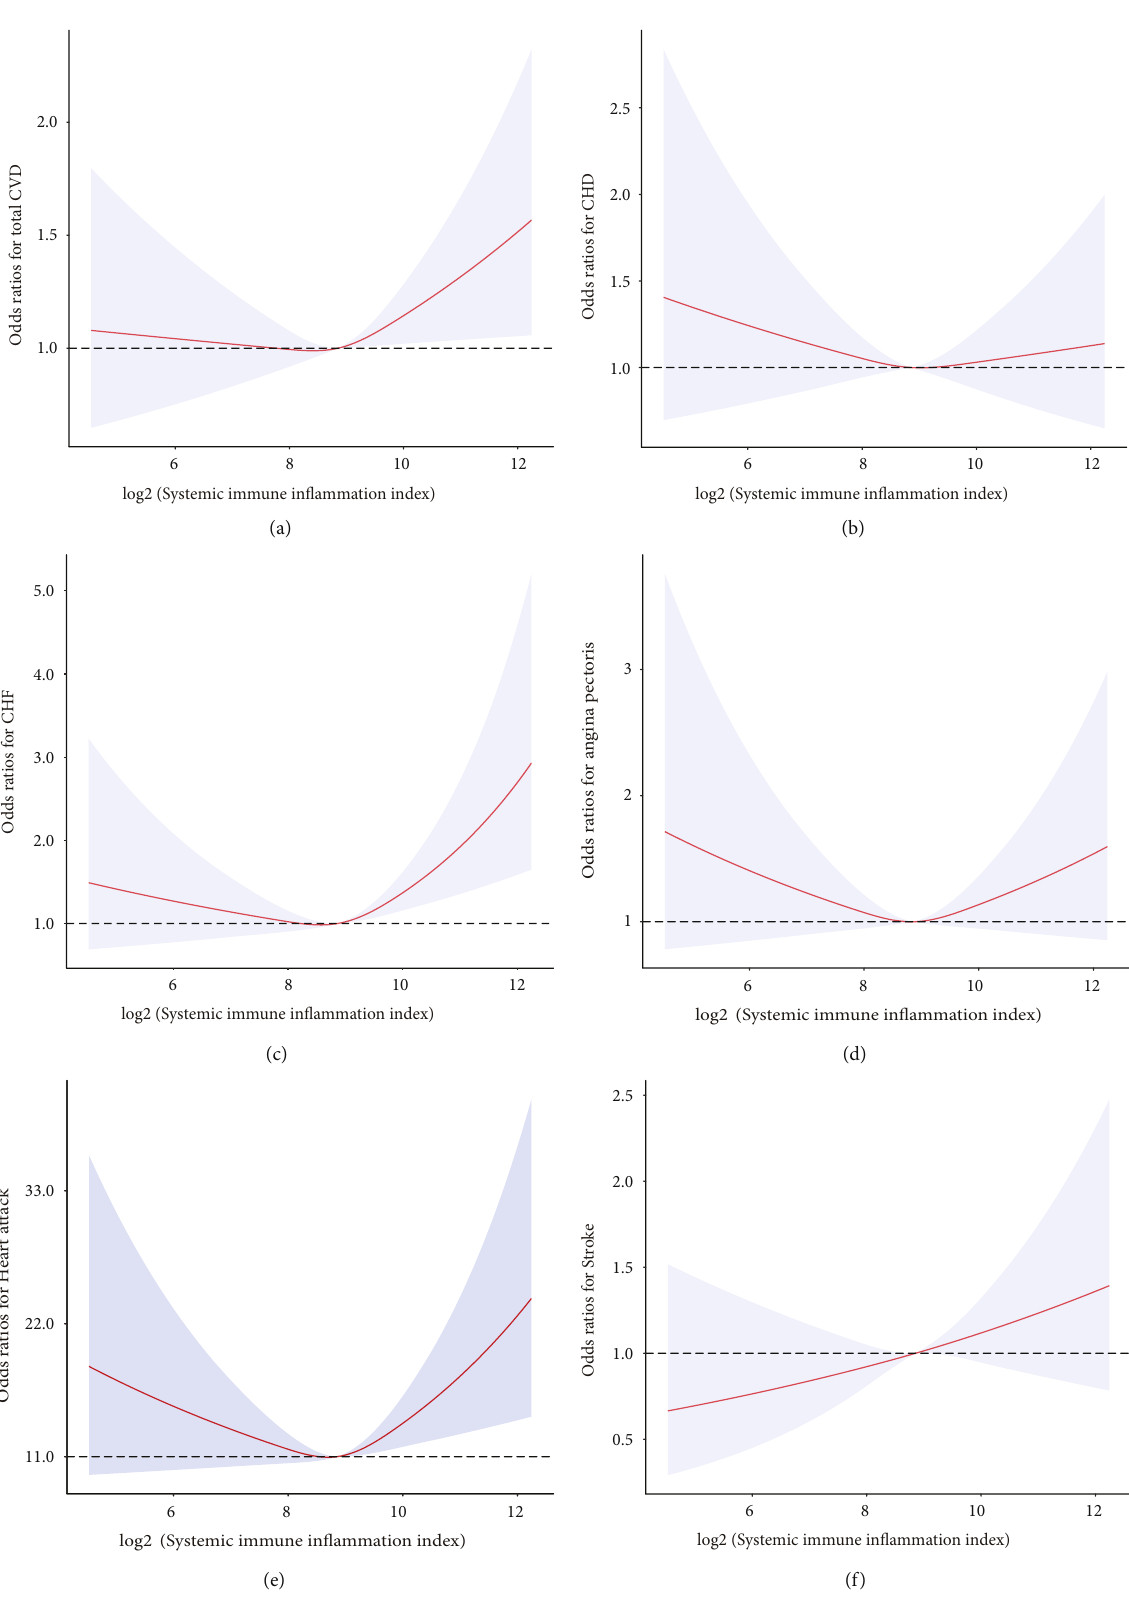
Figure 3: The restricted cubic spline plot of the association between SII index with (a) total CVD, (b) CHD, (c) CHF, (d) angina pectoris, (e) heart attack, and (f) stroke. Abbreviation: SII: systemic immune in fl ammation; CVD: cardiovascular disease; CHD: coronary heart disease; CHF: congestive heart